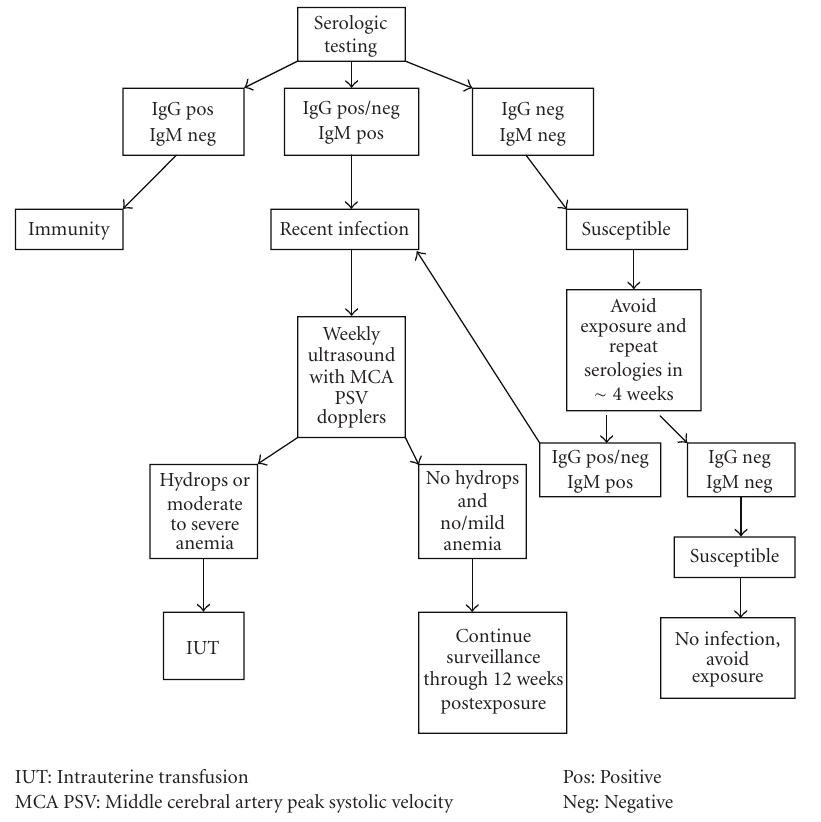
Figure 1: Diagnostic and therapeutic protocol for evaluation of possible parvovirus B19 exposure in pregnancy.